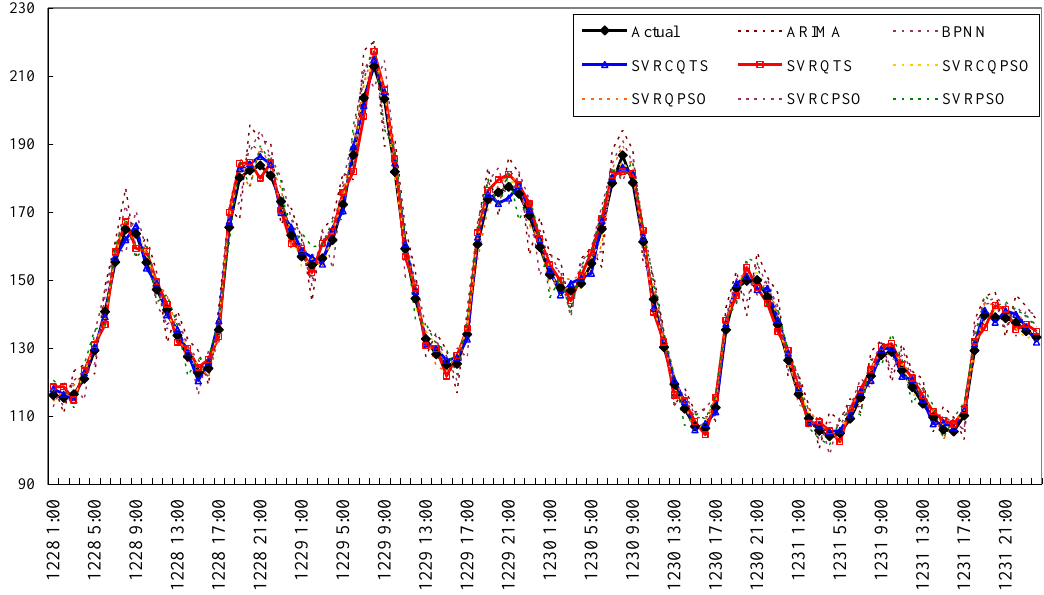
Figure 4. Actual values and forecasting values of SVRCQTS, SVRQTS, and other models (Example 3).